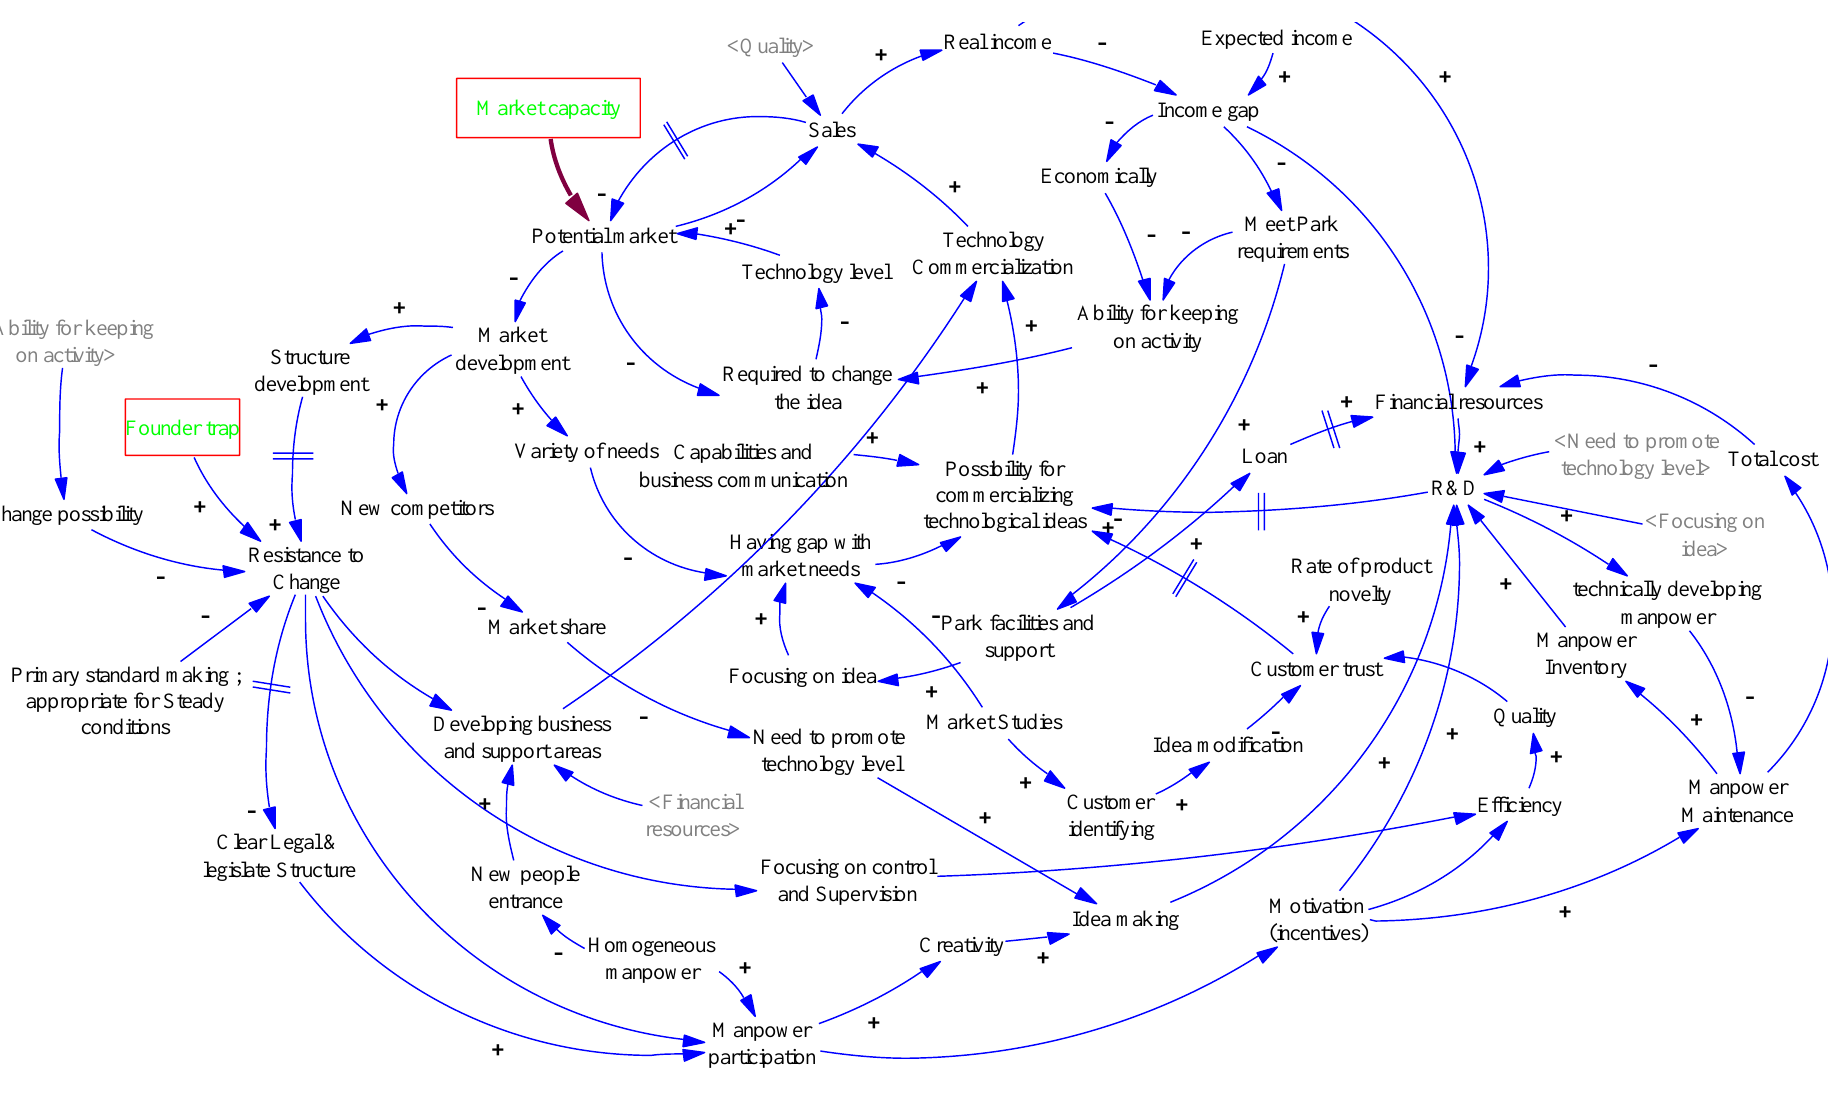
Figure 4. CLD of the